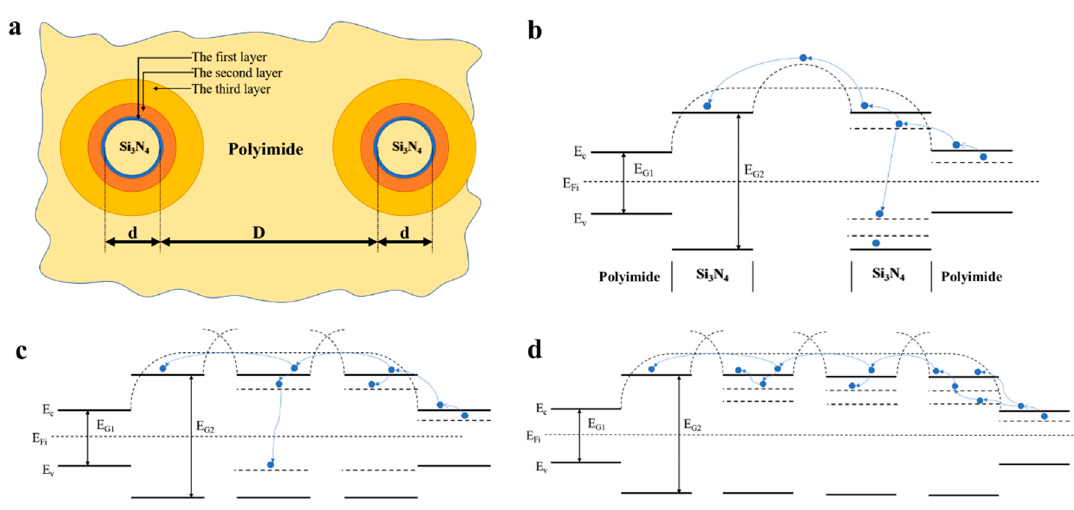
Figure 7. Schematic model of multi-core ( a ) and energy band structure for PI / Si 3 N 4 composite films in different contents: 3 wt.% ( b ), 5 wt.% ( c ), 7 wt.% ( d ).